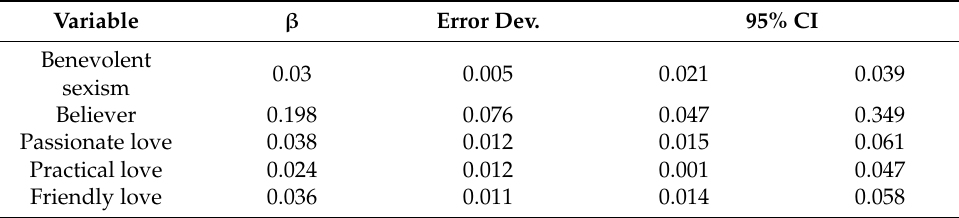
Table 4. Multiple linear regression model for love idealization. Variable